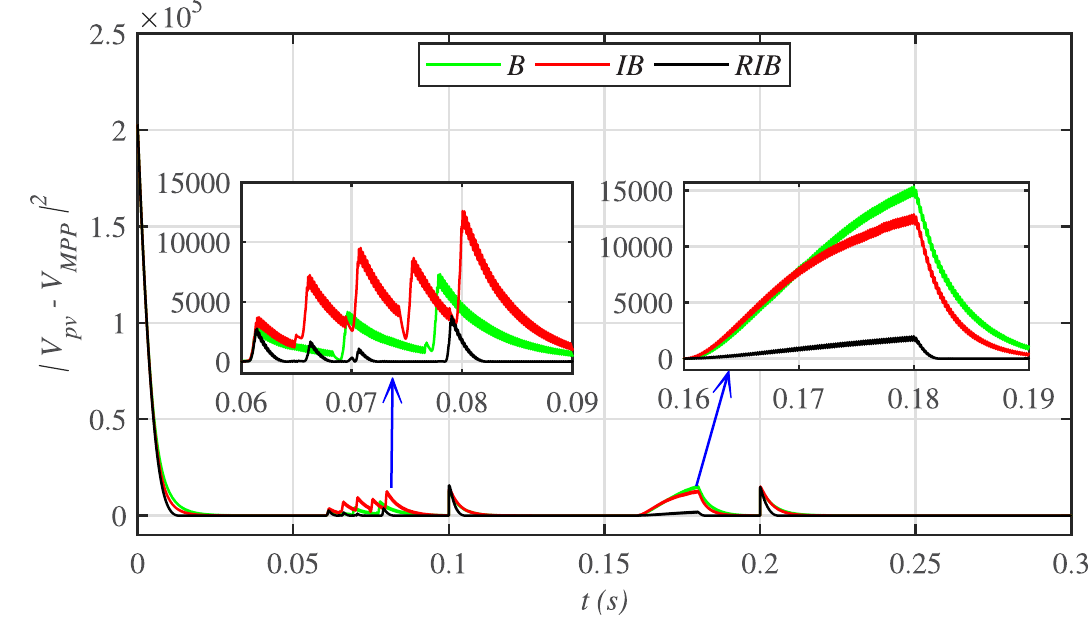
Fig 19. PV array output voltage error comparison under case